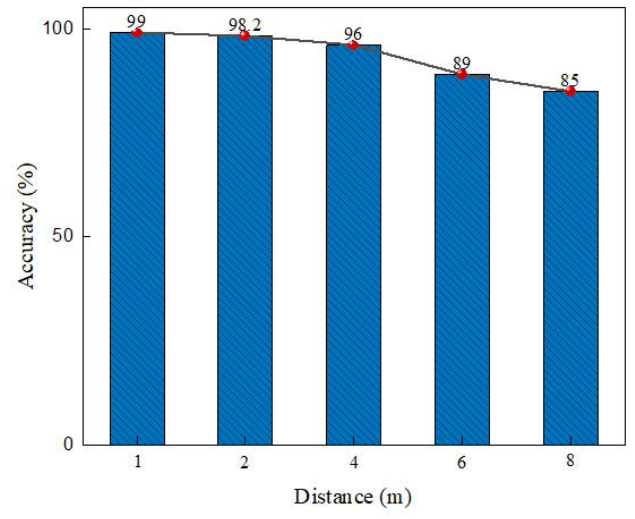
Figure 15. Impact of distance on recognition accuracy.